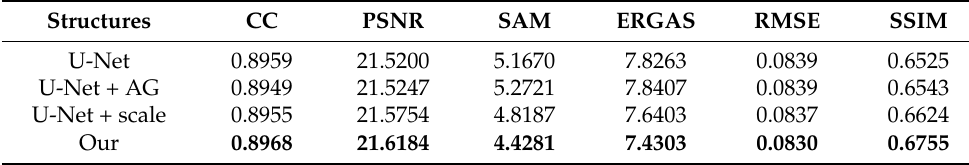
Table 5. The comparison of the results for different structures on IKONOS.